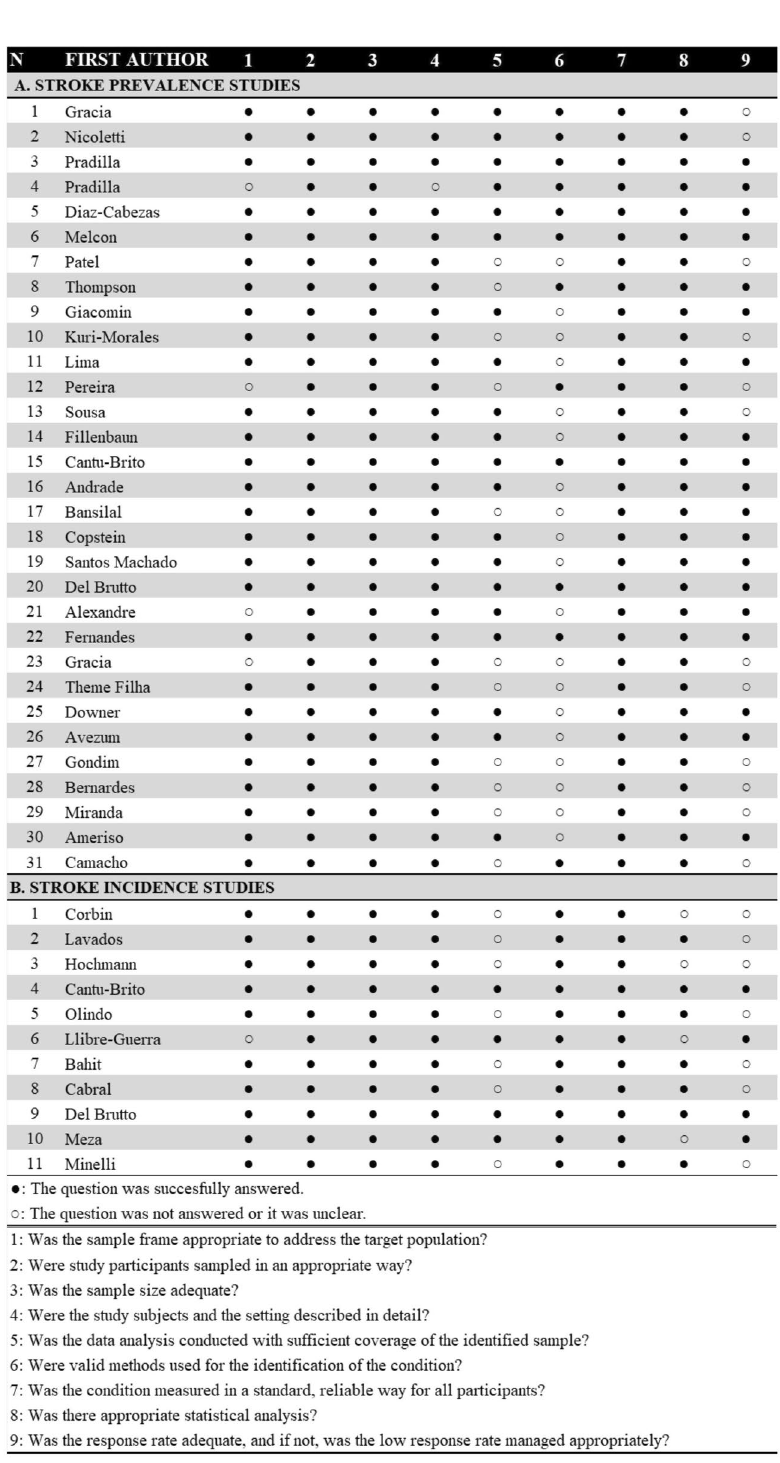
Figure 3. Quality assessment. Assessed with the Critical Appraisal Checklist. ( a ) Prevalence studies. ( b ) Incidence studies. A low risk of bias was defined as ≥ 8 points, and a high risk of bias was defined as < 8 points in the